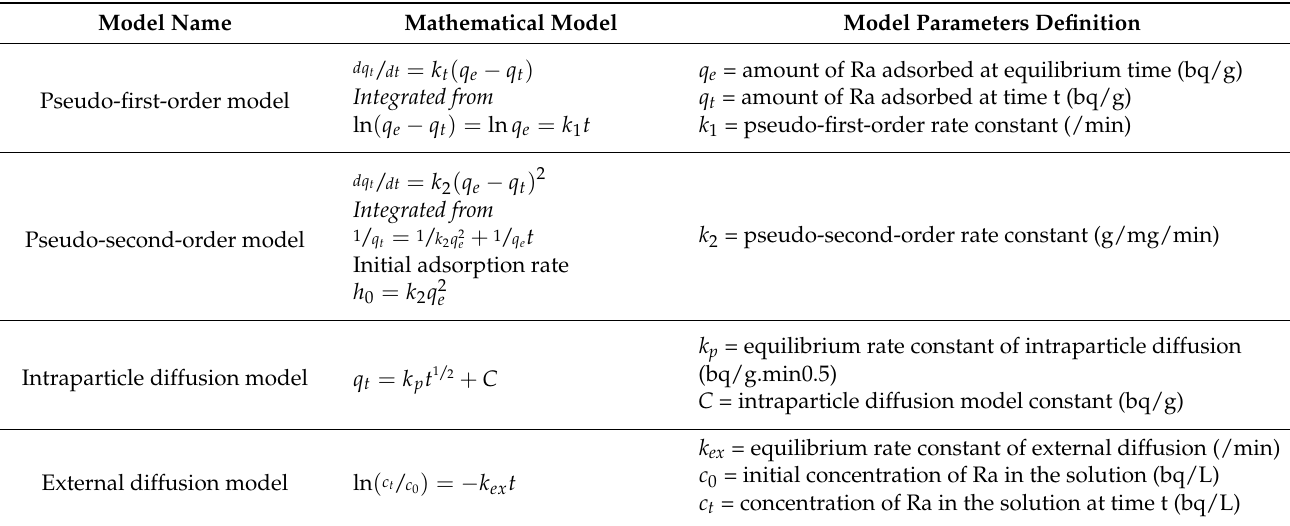
Table 1. Equations for kinetics adsorption